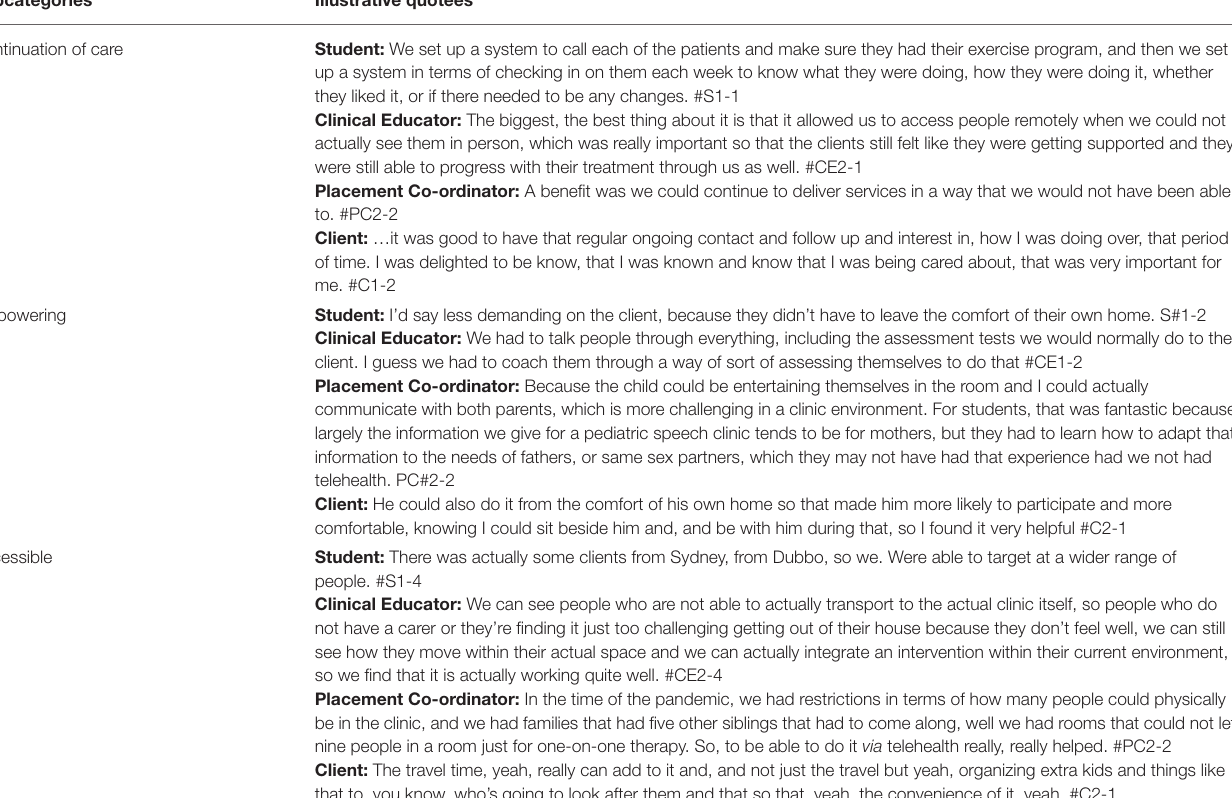
TABLE 3 | Theme 2: Telehealth placements enables students to provide person centered-care.